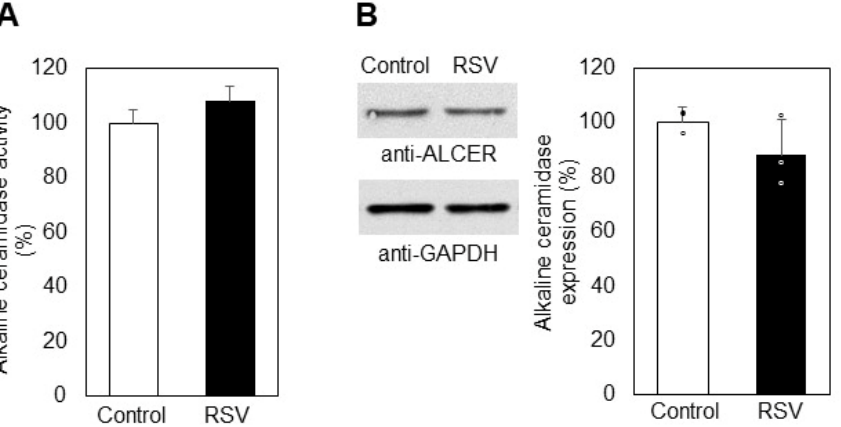
Figure 6. Specific activity ( A ) and protein expression ( B ) of alkaline ceramidase in control (Control, white bars) and resveratrol-treated (RSV, black bars) A549 cells. Values are expressed as % change of control (100%). Representative images from Western blot analysis obtained with antibodies against alkaline ceramidase (anti-ALCER) are shown on the left part of panel B. Reaction with anti-glyceraldehyde-3-phosphate dehydrogenase antibodies (anti-GAPDH) was used as an internal control for loading. Graphical depiction of the percent change in alkaline ceramidase expression is presented on the right part of panel B; ( ᵒ ) stands for the values from each independent experiment, obtained by pooling of three replicate samples. Values are means ± SD. The differences between the obtained values were not statistically significant.